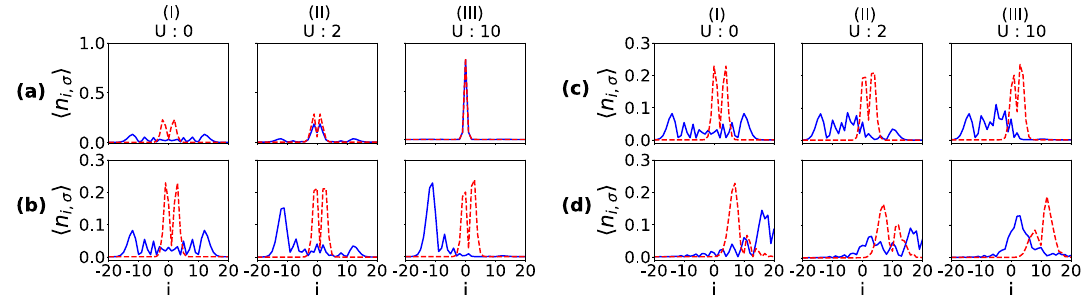
Figure 9. Shows the onsite densities of ↓ (dashed curves) and ↑ particle (solid curves) in the lattice for different regimes of interaction such as small (I), intermediate (II) and large (III) after evolving the initial state up to a certain time ( t ). ( a – d ) correspond to the initial states given in Eqs. (5), (11), (12), (13) respectively. For ( a – c )